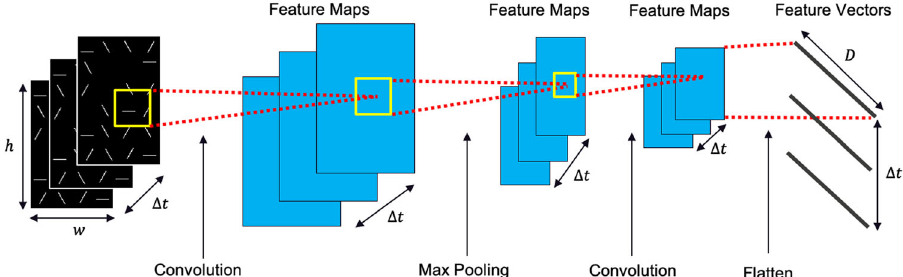
Fig. 5 Architecture of the TI-CNN model. In TI-CNN, the independent convolution kernel for the damage channel at each time step is de fi ned. In this way, the spatial features from the damage channel are extracted without changing the temporal